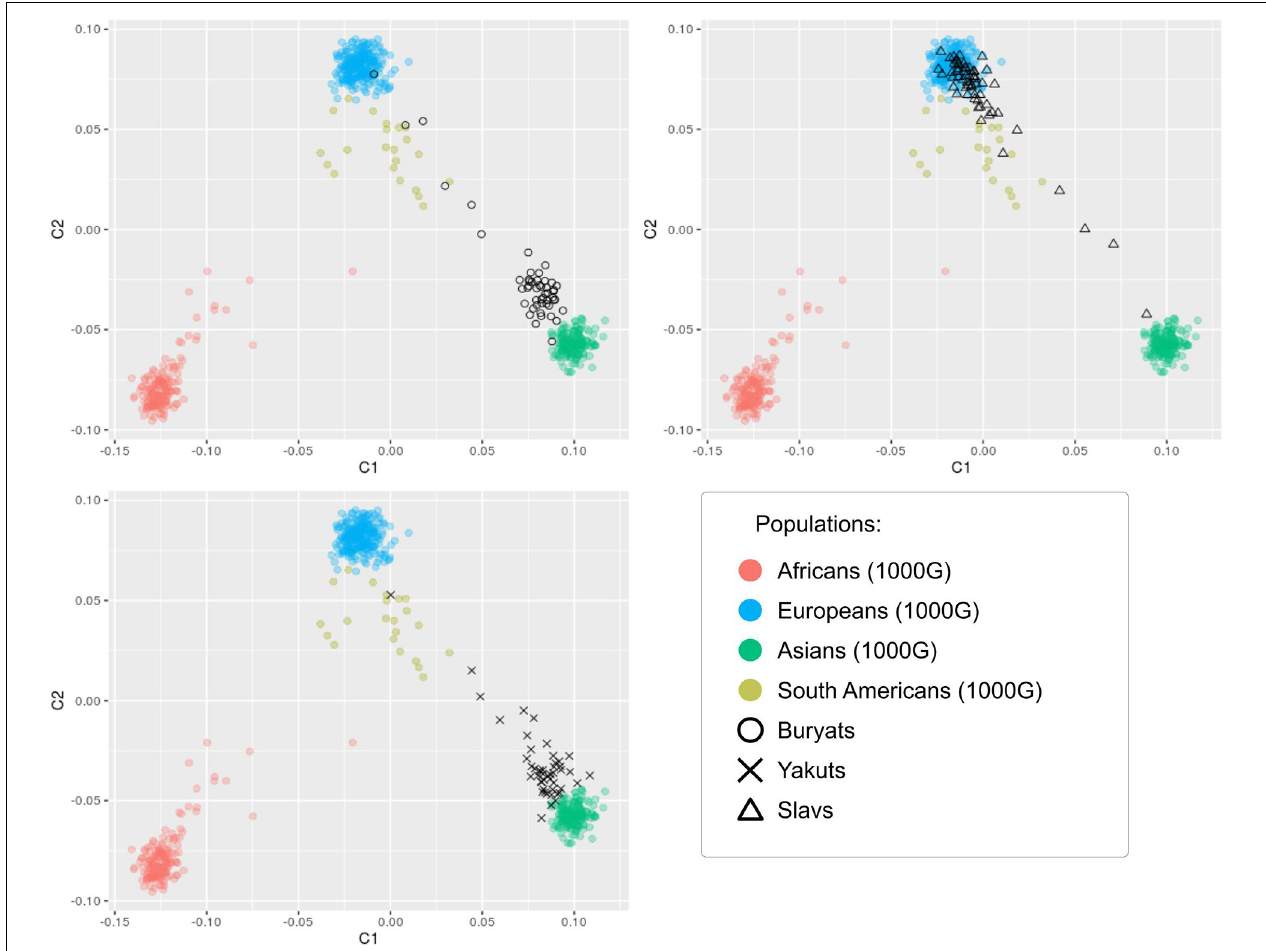
FIGURE 3 | Visualization of the first two components of the results of the multidimensional scaling analysis of 157 samples in the context of other populations.